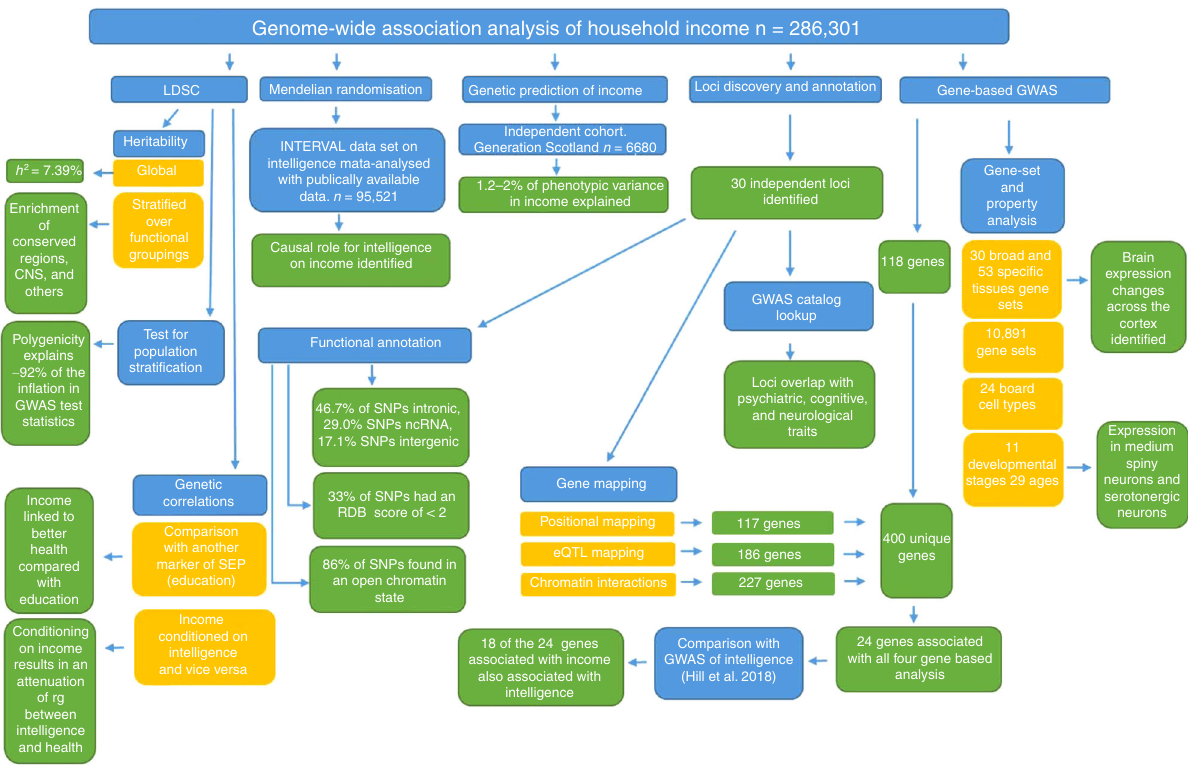
Fig. 2 Flow chart for the statistical analysis carried out using the GWAS data on household income in 286,301 White British participants in UK Biobank. Blue indicates a type of analysis conducted (i.e. LDSC to derive a heritability estimate) and gold indicates a subtype of this type of analysis (i.e. global heritability or the heritability of a subset of SNPs). Green indicates the result of an analysis (i.e. the global heritability was